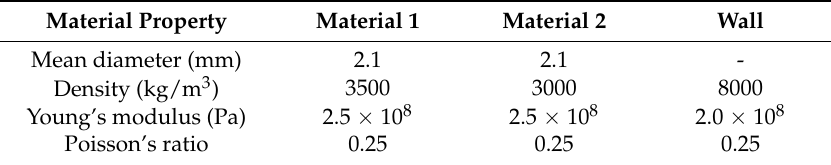
Table 1. Summary of material properties used in the DEM simulations.